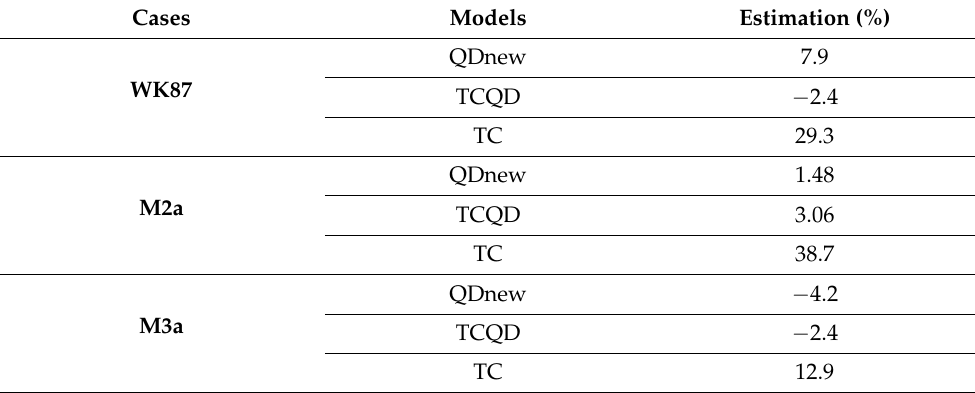
Table 1. Summary of percentage estimation for the model performance of QDnew, TCQD, and TC.